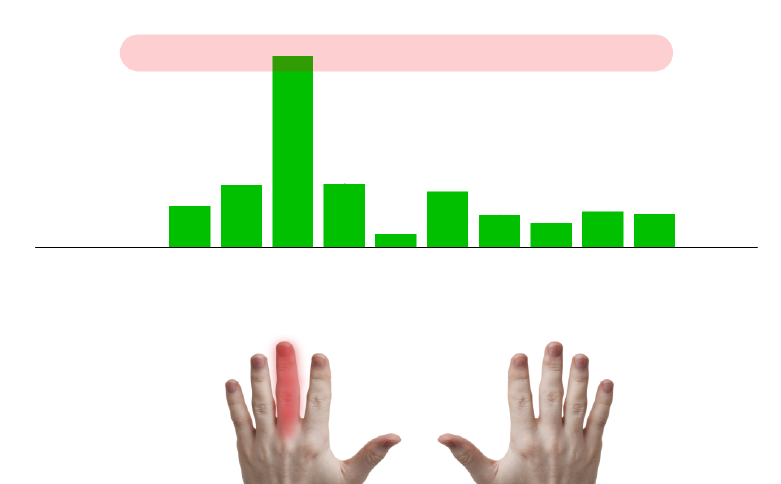
Figure 5. Example of finger force measurement. The required value is in the red area. The measured finger is highlighted and corresponds to the third vertical green bar from the left, and the y-axis represents the applied